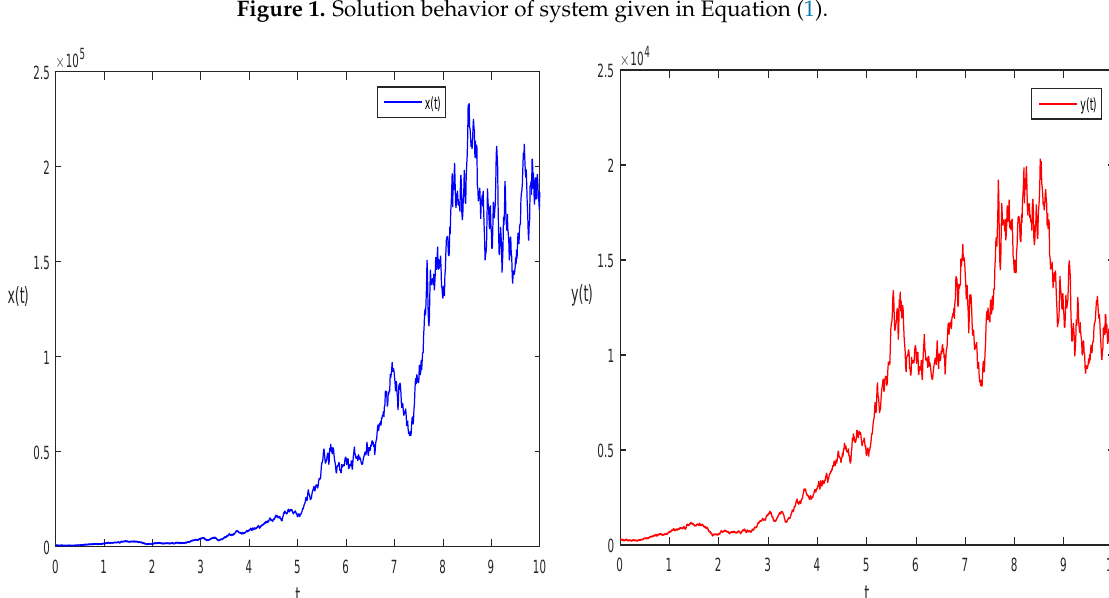
Figure 2. Solution behavior of system given in Equation